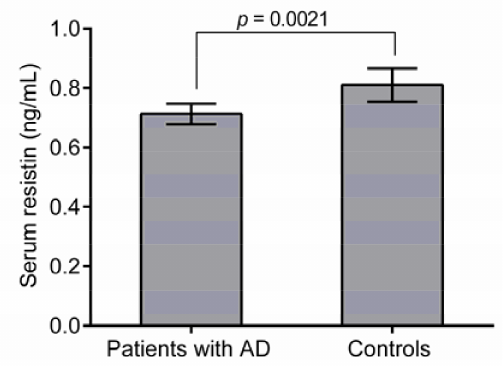
Figure 1. Serum resistin levels in AD and control groups. The data are from 150 subjects (75 patients and 75 controls). Results are mean + SEM. A significant decrease in serum resistin levels in AD patients was detected compared to the control groups ( p =